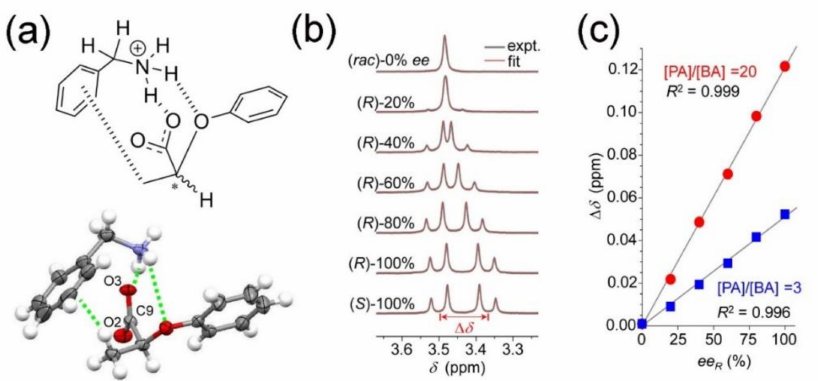
Figure 8. ( a ) Salt complex of benzylammonium ( BA ) with 2-phenoxypropionic acid (( R )- PA ) and its X-ray crystal structure. ( b ) Benzylic CH 2 region of the 1 H-NMR spectra of BA (10 mM) in the presence of ( R )- PA (200 mM) at various ee at room temperature in CDCl 3 solution. ( c ) Dependencies of benzylic CH 2 splitting ∆ δ of BA on the ee of PA (obtained at two different relative concentrations of PA / BA noted) illustrating the linear relationship of ee and ∆ δ . Adapted with permission from Ref. [45]. Copyright 2018 American Chemical